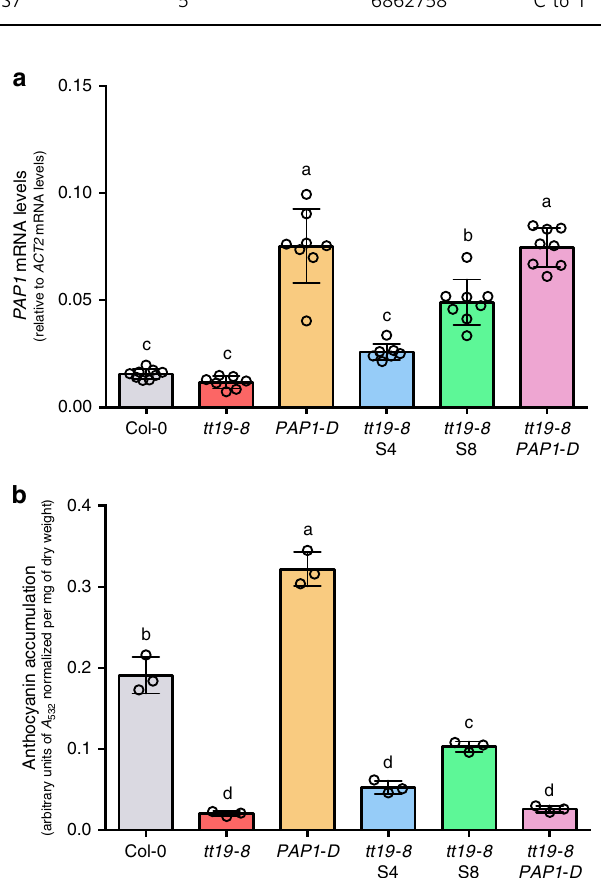
Fig. 2 Over-expression of PAP1 is not suf fi cient to suppress the anthocyanin de fi ciency in tt19-8 . a PAP1 mRNA accumulation levels were evaluated by RT-qPCR and normalized to ACT2 between the various lines of RNA extracted from 4-day-old seedlings grown in AIC. n = 9, 7, 8, 7, 8, 8 biological replicates. b Anthocyanin levels from three independent experiments were measured by A 532 (normalized per mg of dry weight). The error bars represent the standard deviation of the average. Different letters indicate signi fi cant differences between the lines based on one-way ANOVA with Tukey ’ s Honest Signi fi cant Difference test ( P < 0.05). Source data are provided as a Source Data fi